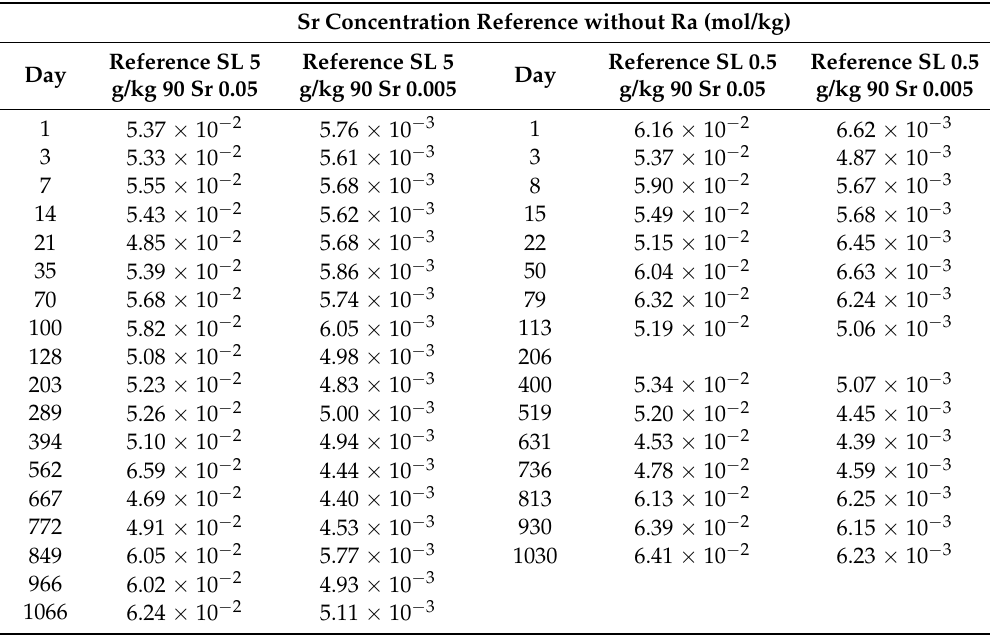
Table A7. Sr concentration of Reference experiments with Sr in the aqueous solution at 90 ◦ C. Sr Concentration Reference without Ra